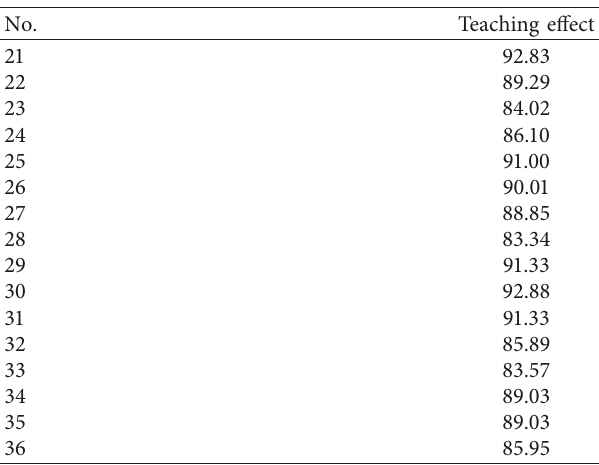
Table 1: Audio frame feature recognition